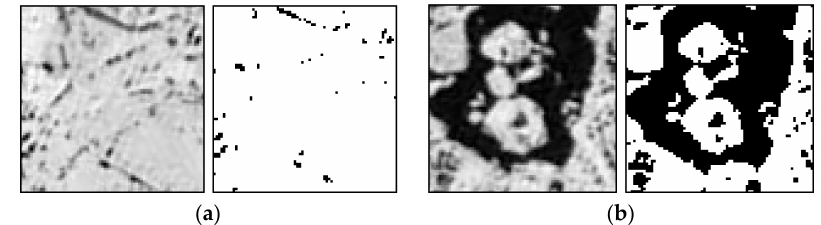
Figure 11. Examples of the sea ice coverage and entropy of the matched block (75 × 75 pixels equivalent to 300 × 300 m ) from the KOMPSAT-2 image acquired on 14 August 2014 (i.e., prior image) and the KOMPSAT-3 image acquired on 14 August 2014 (i.e., posterior image), resampled to the spatial resolution of 4 m: ( a ) 14 bit grey scale image block and binarized sea ice image block showing the maximum sea ice coverage parameter (97.849) and 3rd lowest entropy (0.150) of the prior image; and ( b ) 14 bit grey scale image block and binarized sea ice image block showing the maximum entropy (1.000) and the sea ice coverage parameter around 50% (50.08) of the prior image. The image blocks were chosen from the blocks designated as the cross-correlation coefficients higher than 0.6, and after additional outlier